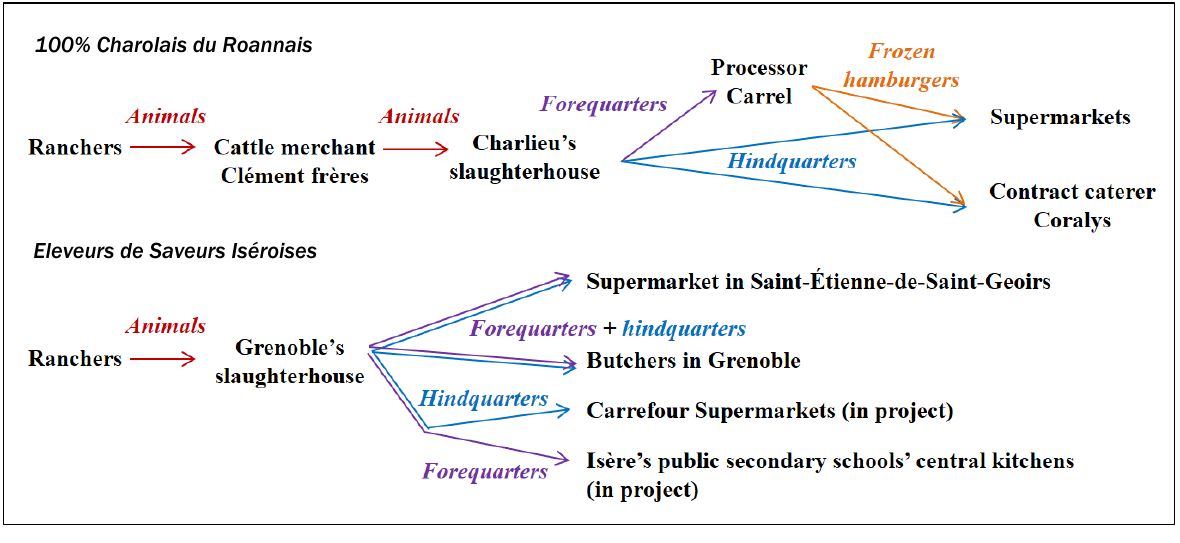
Figure 1. Actors and Supply Chains in the 100% Charolais du Roannais and Eleveurs de saveurs iséroises Initiatives at the End of